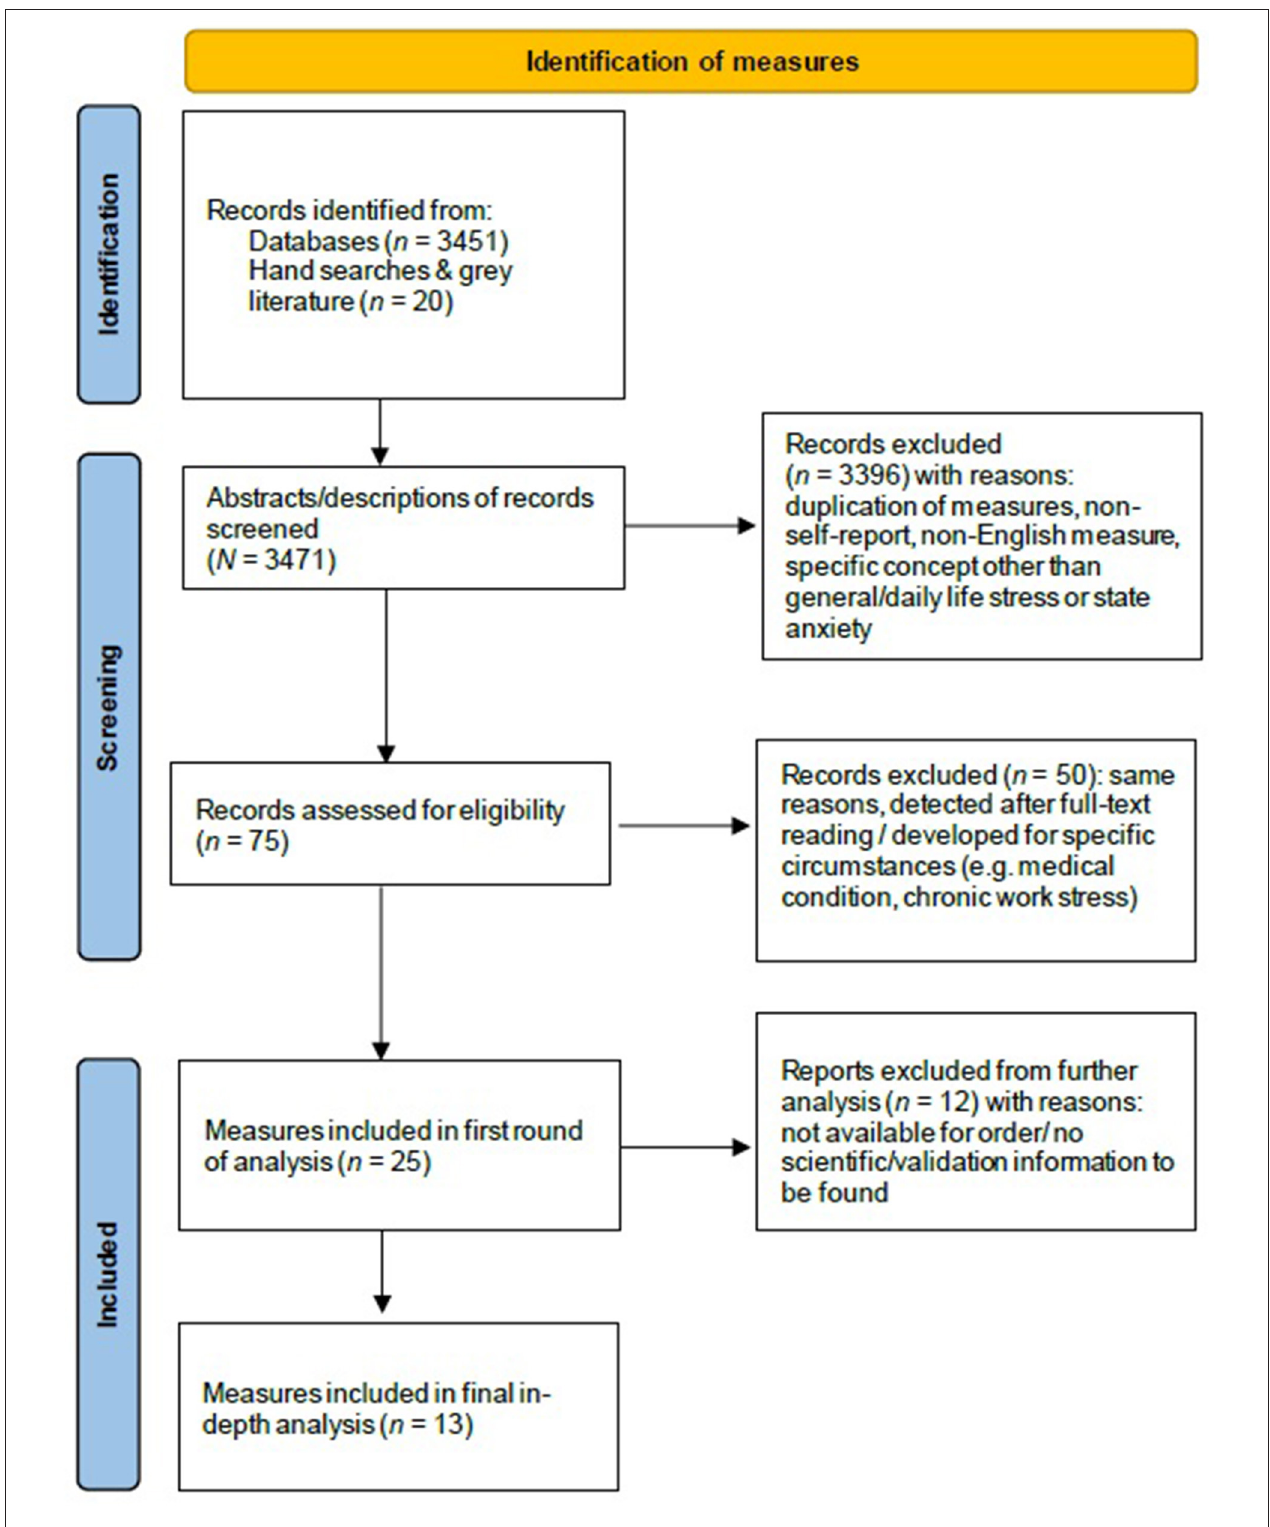
FIGURE 1 | Flow diagram of the selection